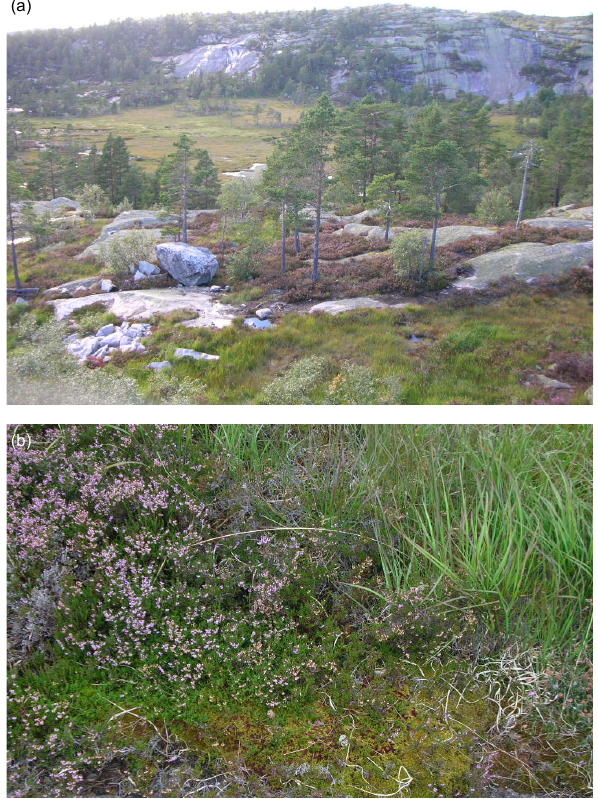
Figure 1. (a) A general view of the study area, Storgama, show- ing soil occurring in pockets and small depressions at the bedrock surface; note that close-up vegetation at the bottom right is dom- inated by Molinia caerulea (L.), the understorey of pines beyond is Calluna vulgaris (L.) Hull., and the basin in the background is covered by Sphagnum spp. (b) A rare coalescence of the three dom- inant species – Calluna vulgaris , on the left; Sphagnum spp. L., at the bottom; and Molinia caerulea , on the